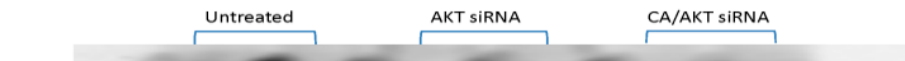
Figure 2. MAPK protein expression in MCF-7 cells. Cells were treated with media (untreated), free MAPK siRNA, and CA/MAPK siRNA formed with 3 mM of CaCl 2 and 1 nM siRNA for 44 h. Cellular lysates were resolved by SDS-PAGE and transferred into PVDF membrane followed by incubation with primary antibodies raised in rabbit against AKT. HRP-conjugated goat anti-rabbit secondary antibody was used to detect the chemiluminescent signals. Next, changes in protein expression resulting from the combinations of drugs and siRNAs, as highlighted in the cell viability data, were studied. MCF-7 cell lysate treated with free and CA-bound AKT siRNA, CA/AKT/Pac and CA/Pac were loaded on the gels. According to the resulting bands (Figure 3), the lowest level of AKT protein was obtained by CA/AKT/Pac treatment versus CA/Pac or CA/AKT. This implies the development of synergistic interactions to suppress survival pathways in the presence of classical anti-cancer drugs together with genetic downregulation of survival proteins, which in turn might lead to enhanced sensitivity of the cells to the anti-cancer medication.